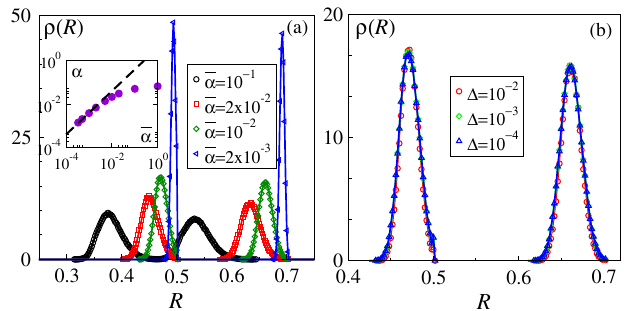
FIG. 1. (a) Distribution of radii ρ ð R Þ for different ¯ α at fixed Δ ¼ 10 − 4 and for different Δ at fixed ¯ α ¼ 10 − 2 . (b) Inset: α versus ¯ α compared to a linear relation in black. Data are averaged over 1000 systems with N ¼ 484 particles. For ¯ α ¼ 10 − 2 , the widths of the distributions are given by α 1 ¼ 0 . 024 and α 2 ¼ 0 . 018 for the smaller and bigger radii, respectively.